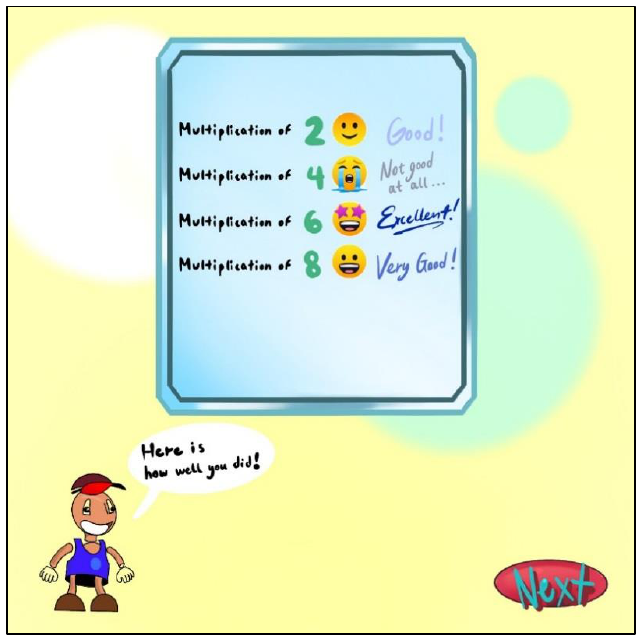
Figure 5. Pupil’s progress after completion of second scene.